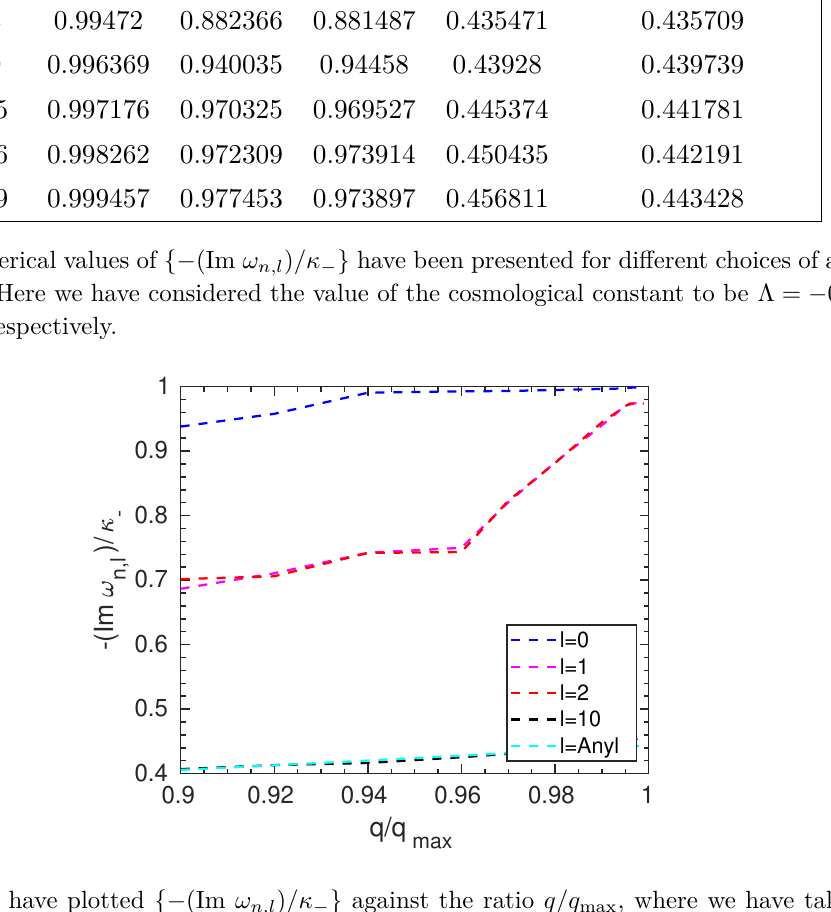
Figure 5 . We have plotted {− ( Im ω n,l ) /κ − } against the ratio q/q max , where we have taken the value of the cosmological constant Λ = − 0 . 1 and the mass M = 1 , for different choices of angular momentum ‘